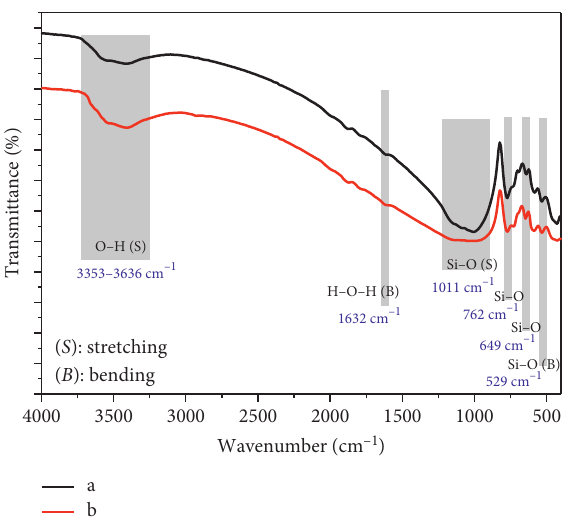
Figure 2: XRD analysis and FTIR analysis of ground Rosa Porrino (a) and Gris Pinhel